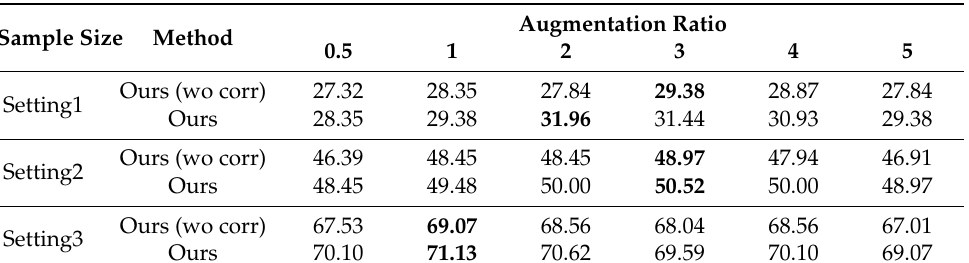
Table 4. Classification accuracy (%) with different augmentation ratios on the eNTERFACE’05 dataset. Best results are shown in